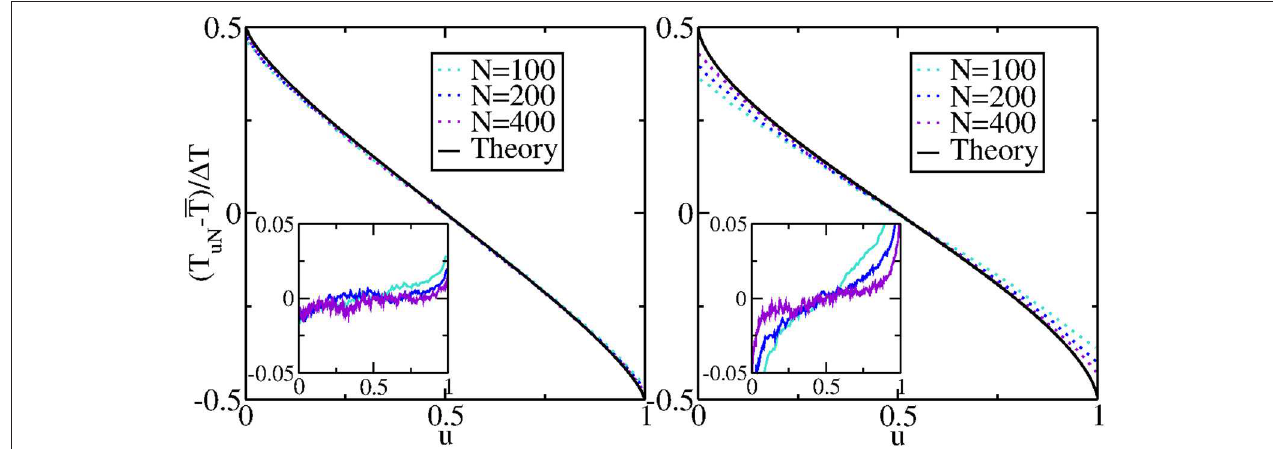
1 (right). In the main plots results of Monte-Carlo simulations for 2 =